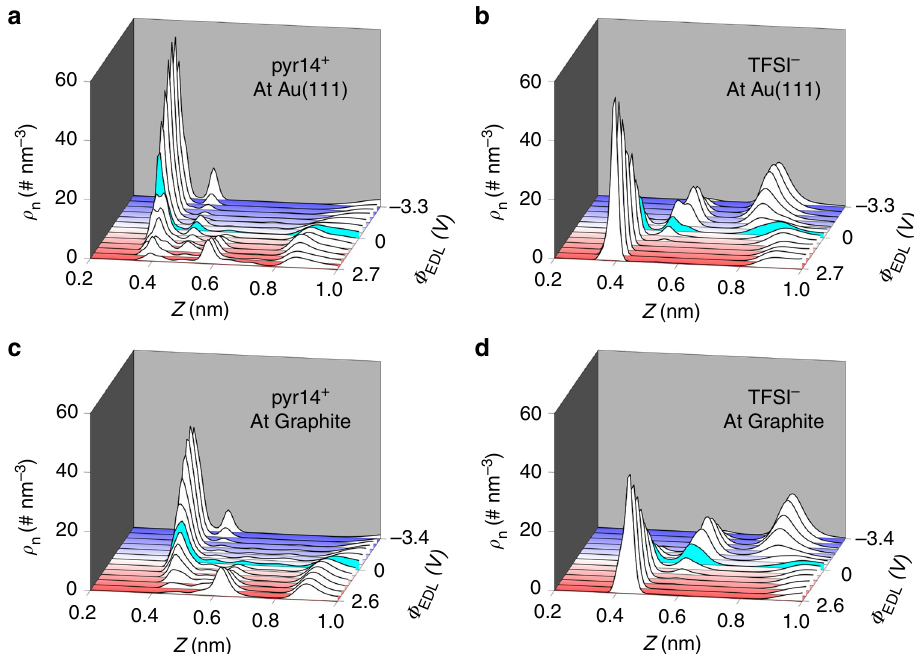
Fig. 1 Effects of the electrode material on interfacial ion distributions. Ion number density ( ρ n ) as a function of distance from the electrode ( Z ) under different electrical double layer (EDL) potential ( Φ EDL ). a – d Cation 1-butyl-1-methylpyrrolidinium (pyr14 + ) ( a ) and anion bis(tri fl uoromethylsulfonyl)imide (TFSI − ) ( b ) number density pro fi les near gold surface. pyr14 + ( c ) and TFSI − ( d ) number density pro fi les near carbon surface. Blue and red colors highlight negative and positive potential biases, respectively. Note that planes across centers of surface atoms of carbon and gold electrodes are located at Z = 0 nm, but the results are displayed in the relevant range of 0.2 nm< Z <1 nm. Through this work, number density is computed based on the center of mass